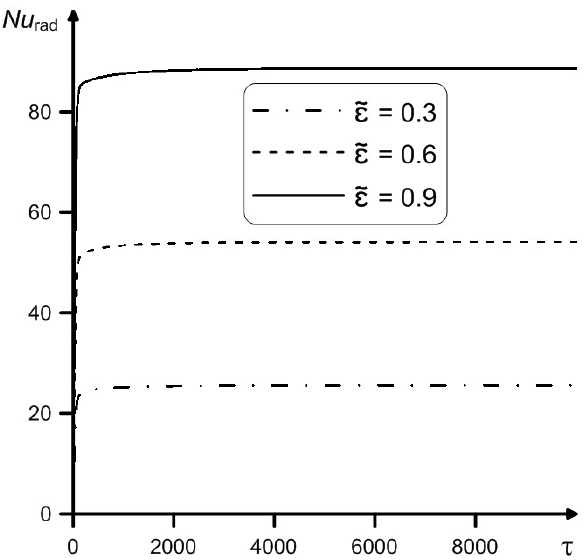
Figure 6. Profiles of the average radiative Nu vs. time and surface emissivity at Ra = 10 9 , Pr = 0.7, λ w,air = 10000, h / L = 0.2. λ w,air = 10,000, h / L = 0.2.